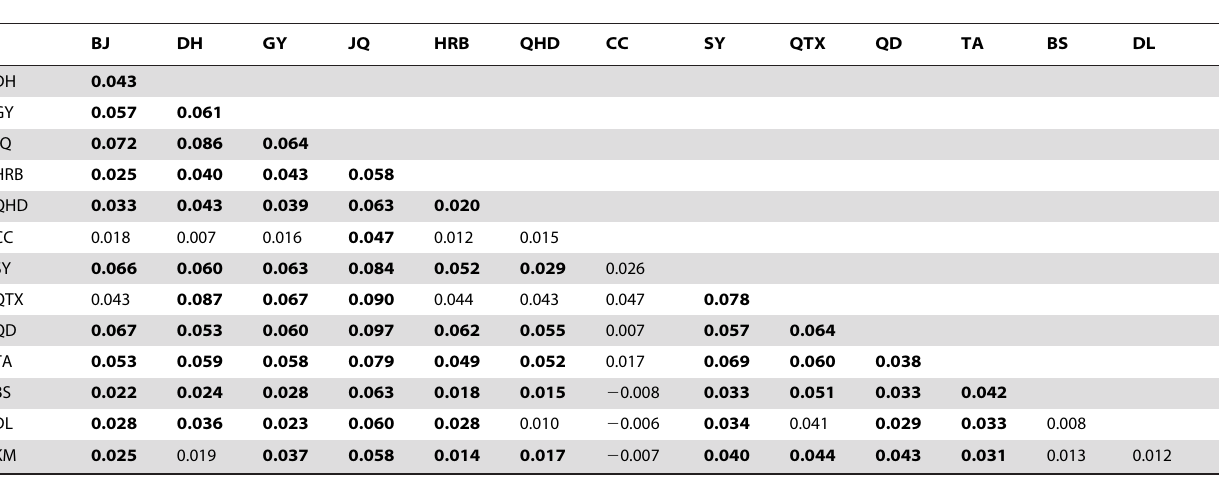
Table 4. Pairwise F ST matrix obtained using 10 microsatellite loci.